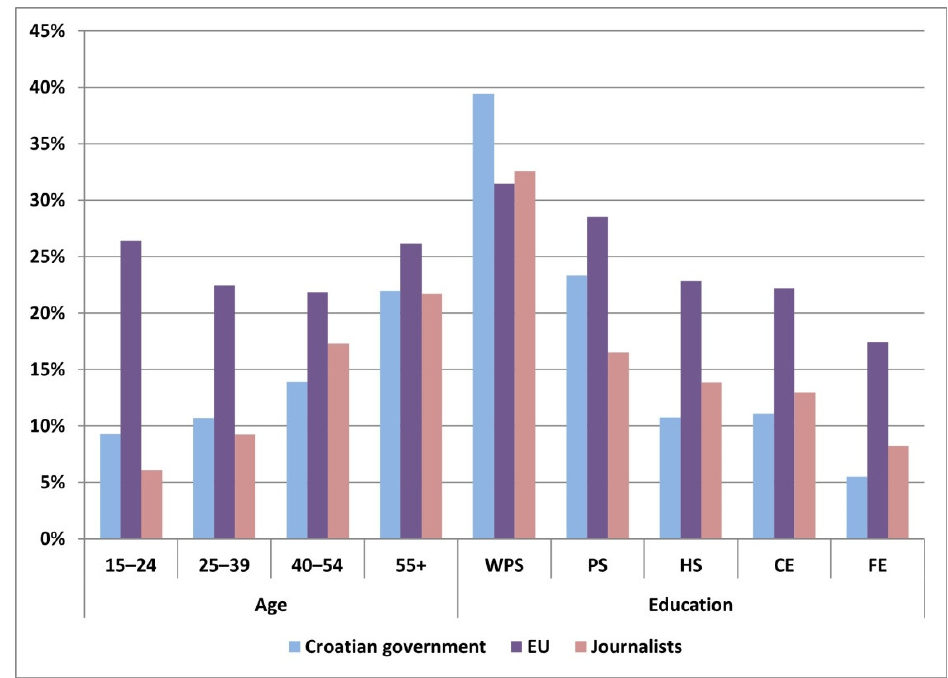
Figure 13. Age and education impact on selected sources of information.